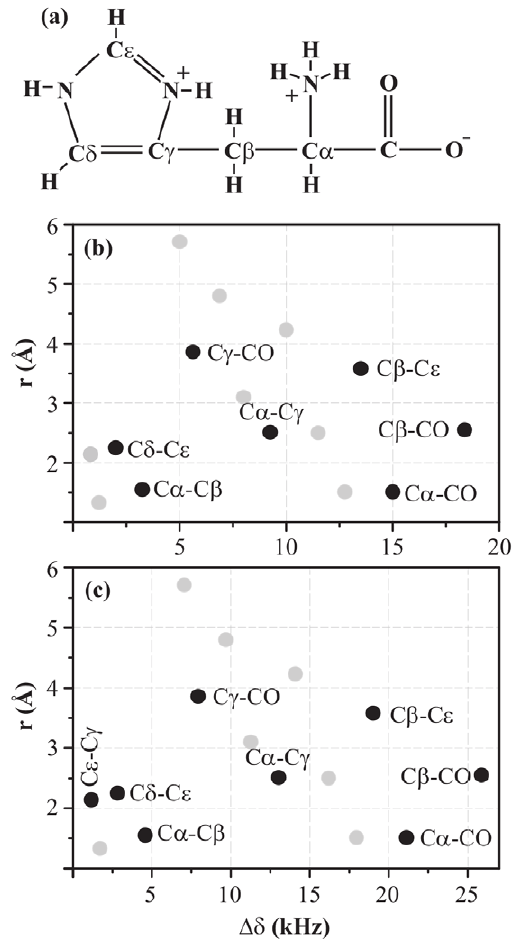
Figure 2. 2D 13 C- 13 C spin-diffusion spectrum. (a) A schematic molecular structure of histidine molecule. A map of all possible cross- peaks in a 2D 13 C- 13 C spin-diffusion spectrum of U- 13 C-, 15 N-L- histidine : H 2 O as a function of chemical-shift difference (along X axis) and spatial distance (along Y axis) between two carbon atoms at magnetic fields of (b) 11.74 and (c) 16.43 T. Highlighted cross-peaks are the ones which are studied in this work.